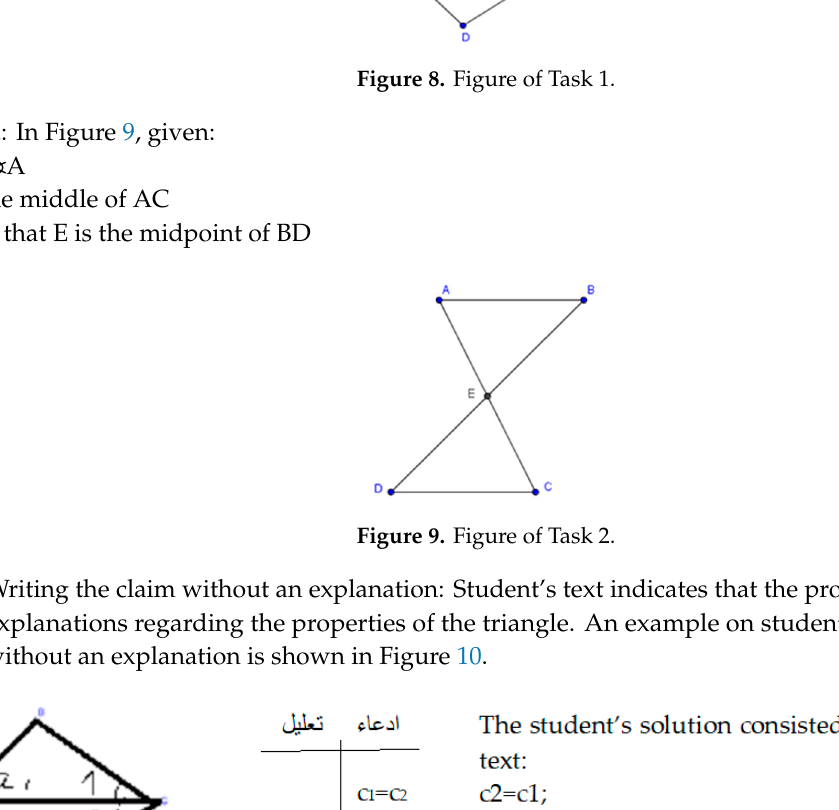
Figure 12. One of the conditions is missing. •